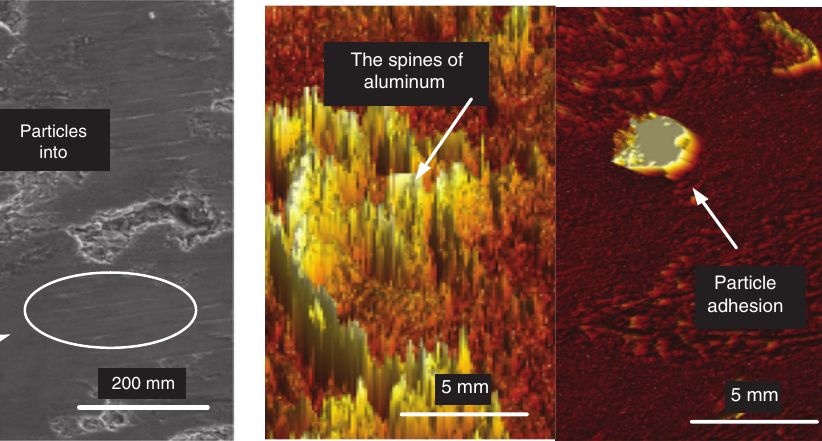
Figure 6: Aluminum spurs and particle